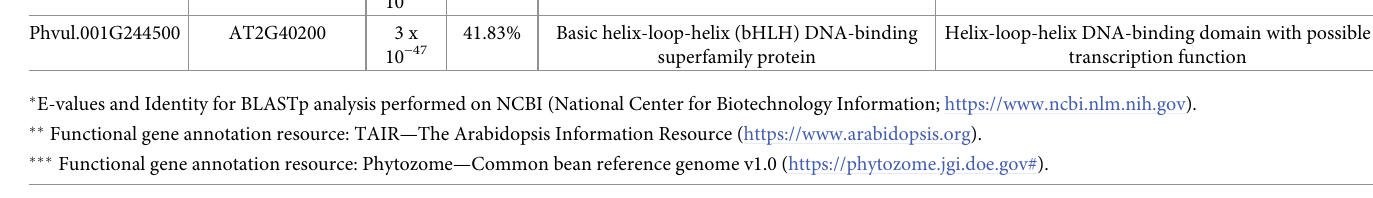
Helix-loop-helix DNA-binding domain with possible transcription